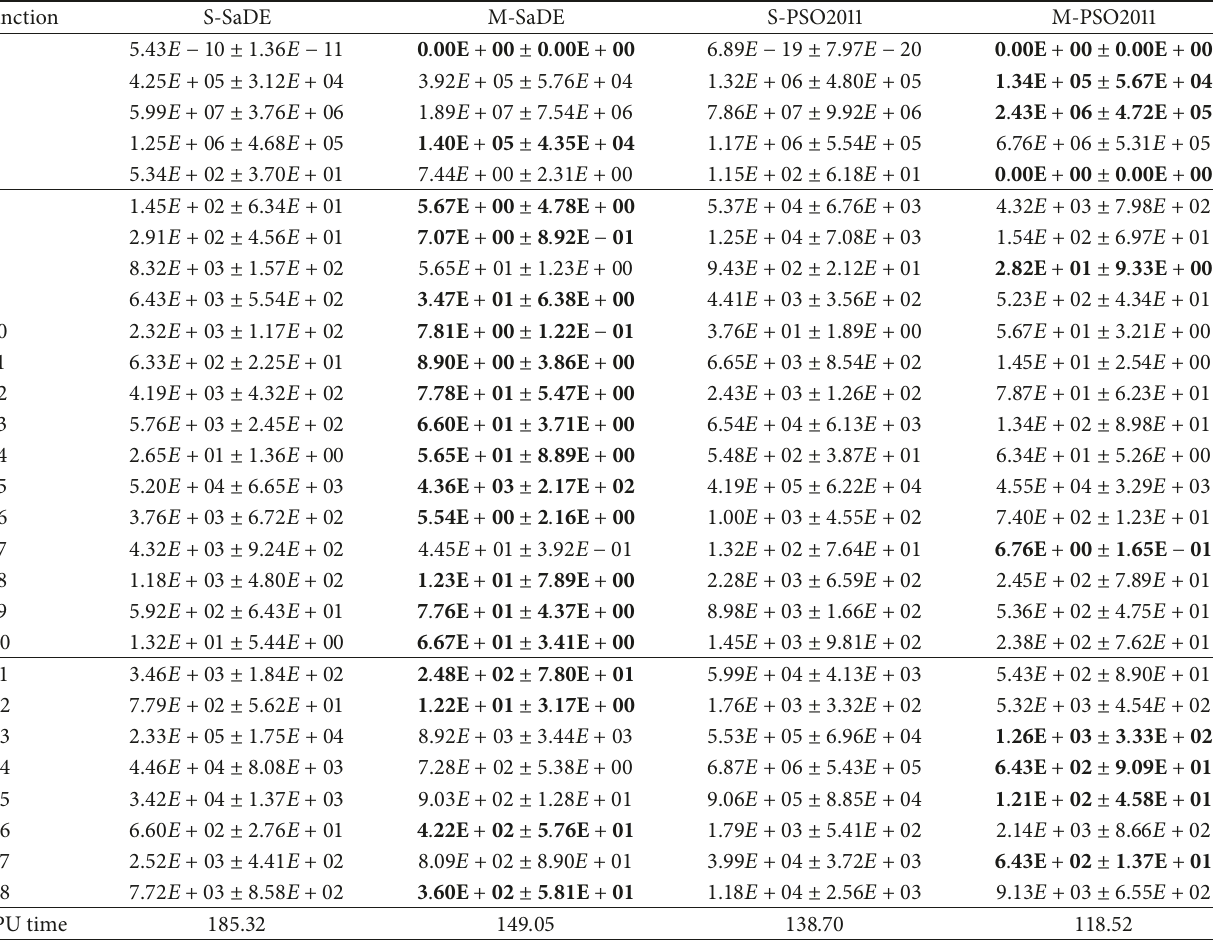
Table 3: Comparisons of the best error values of the 2013 CEC benchmark functions for SaDE and PSO2011. In the table, “S-” and “M-” denote the single-population version and multipopulation version of algorithms, respectively. Here [ 𝑎 ± 𝑏 ] indicates the mean value and the corresponding standard deviation of 25 independent simulations. The best result in each row (Tables 2 and 3 combined) is shown in bold font . Average CPU times (minutes) are shown in the last row of the